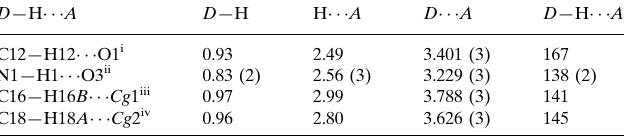
Hydrogen-bond geometry (A˚ , (cid:1)